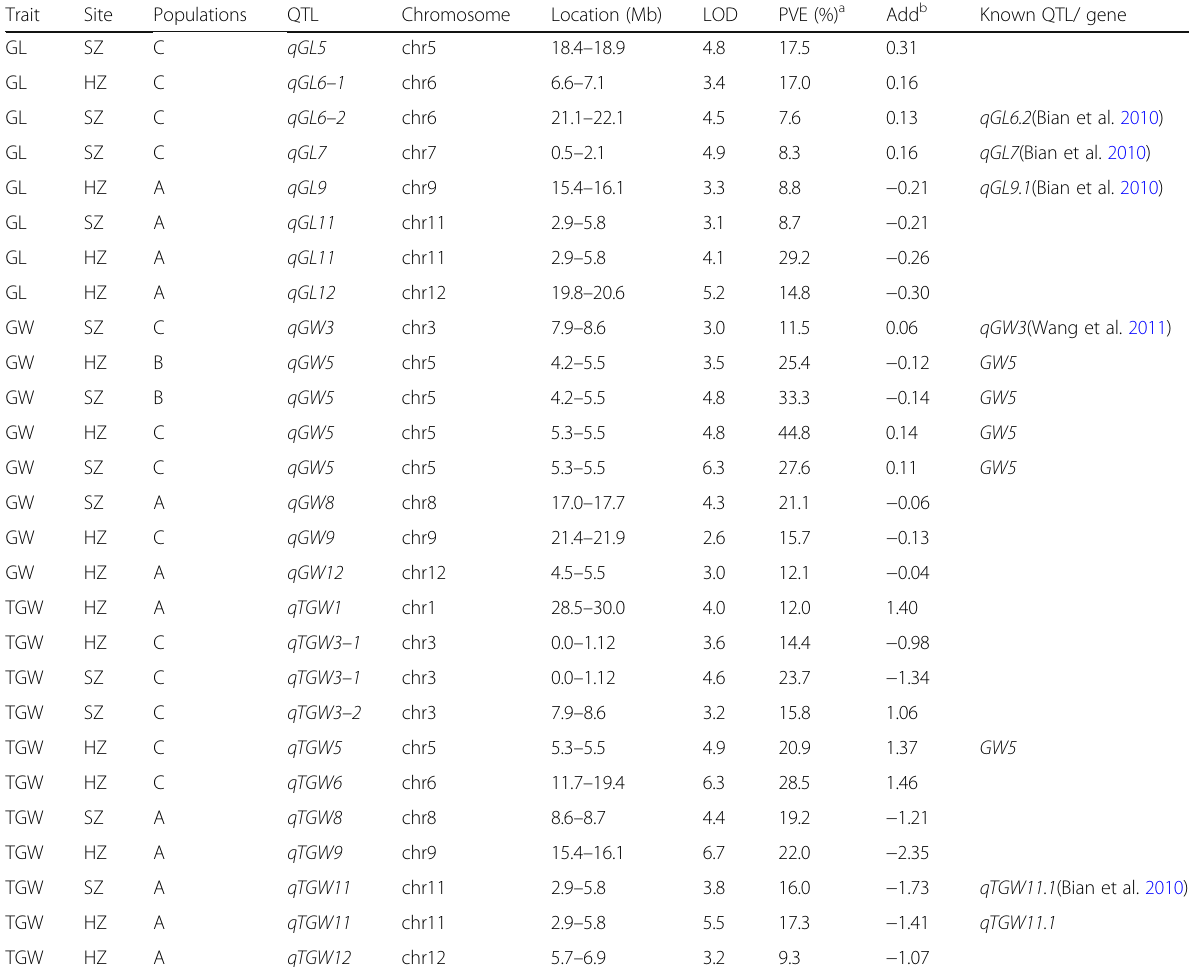
Table 2 QTLs for 11 traits detected in 3 sets of CSSLs in Shenzhen (SZ) and Hangzhou (HZ) (Continued)